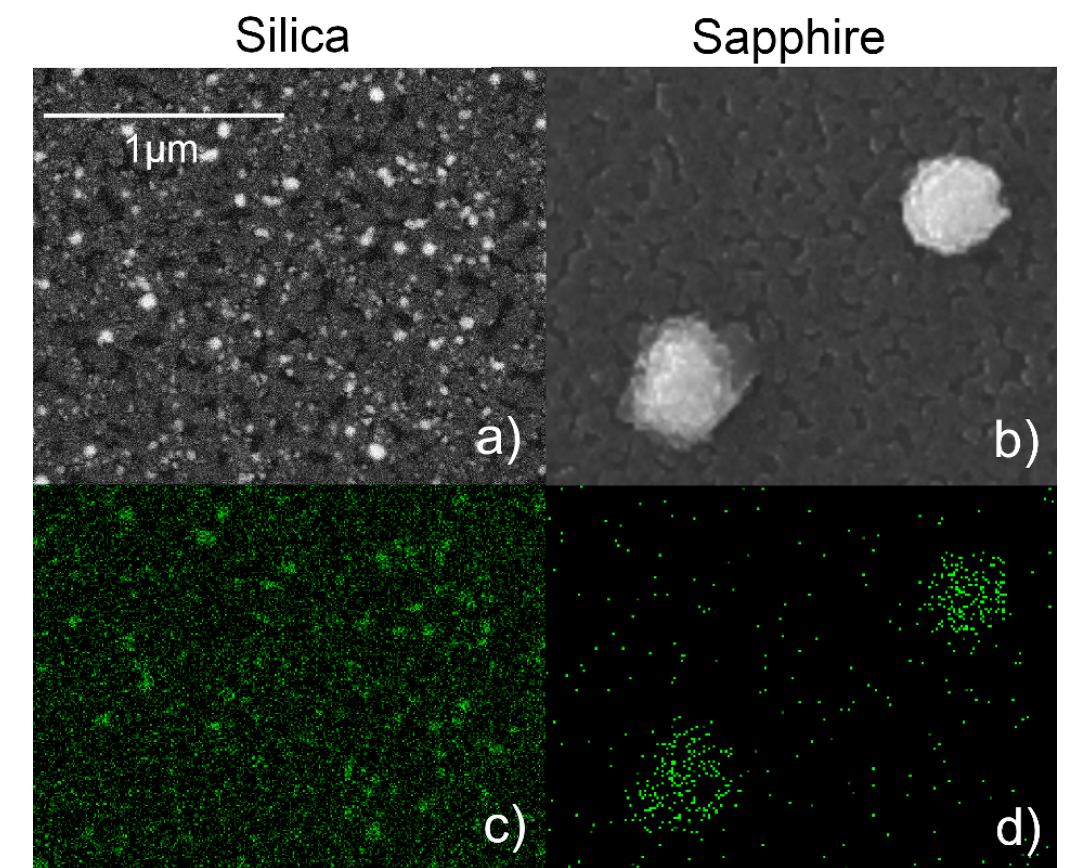
Figure 4. ( a ) SEM image (backscattered mode) of the Ag/TiO 2 (AgTi 50–50) film on silica after annealing at 900 ◦ C for 1 h. ( b ) SEM image (secondary electrons) of the Ag/TiO 2 (AgTi 50–50) film on sapphire after annealing at 900 ◦ C for 1 h. ( c ) EDX map of the Ag La emission acquired on the same area of ( a ). ( d ) EDX map of the Ag L α emission acquired on the same area of ( b